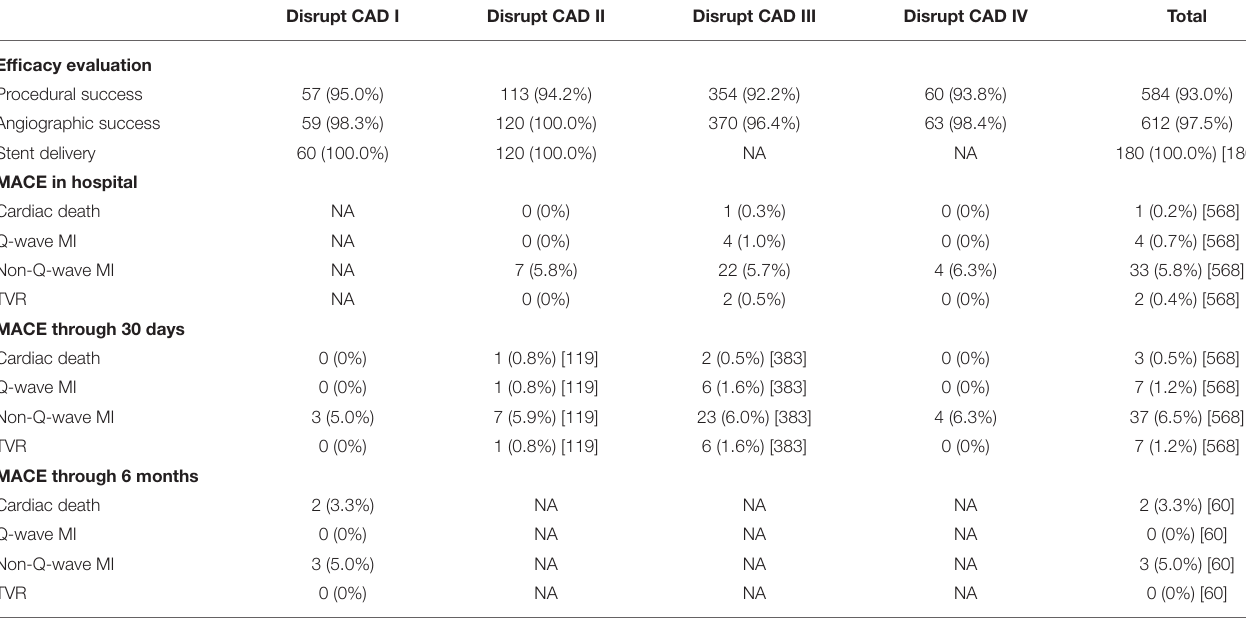
TABLE 5 | Clinical outcomes.